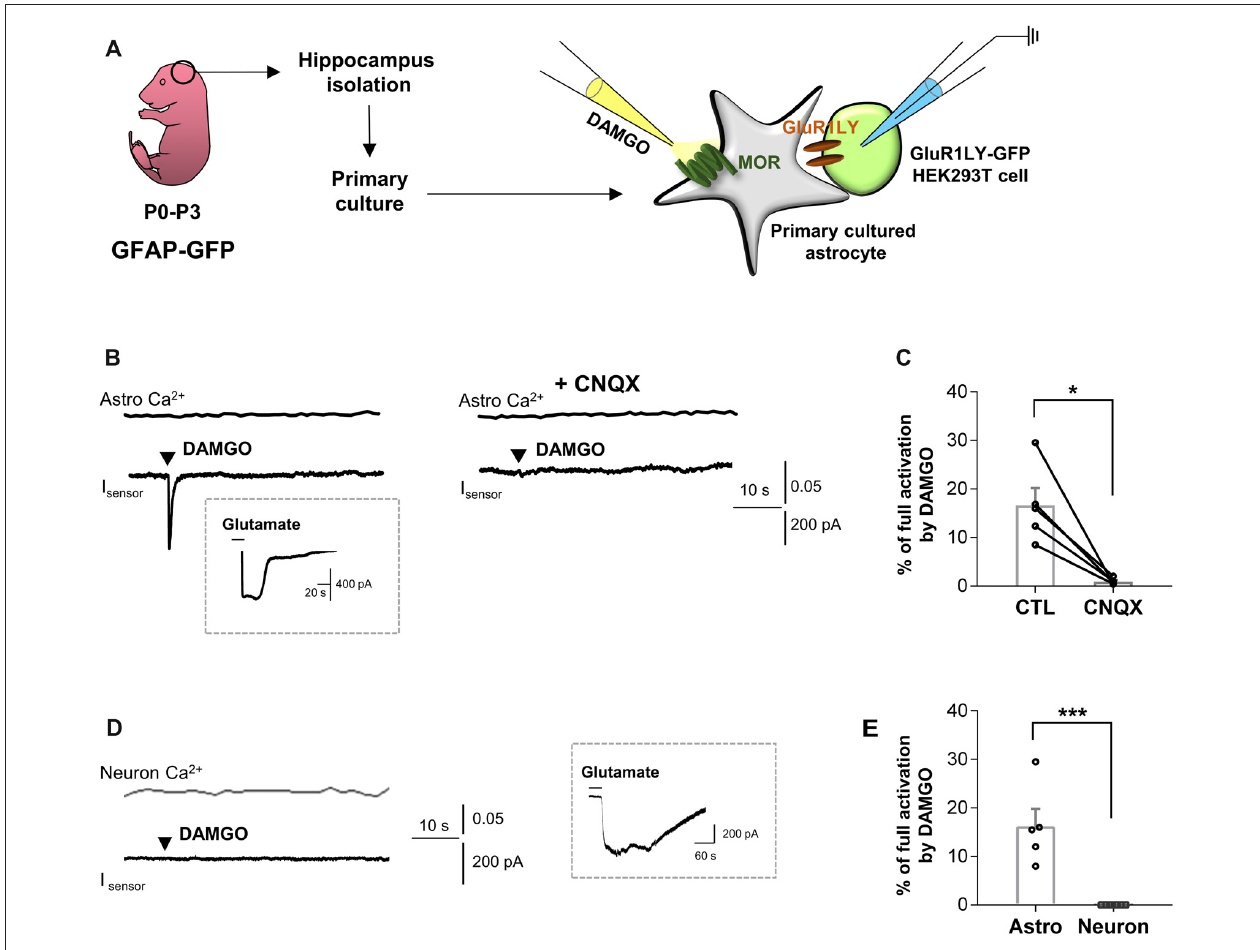
FIGURE 1 | µ -opioid receptor (MOR) activation elicits fast glutamate current from hippocampal astrocytes. (A) Schematic diagram for sniffer-patch with primary cultured hippocampal astrocytes prepared from GFAP-green fluorescent protein (GFP) mouse and GluR1LY-GFP-expressing HEK293T biosensor cells. (B) Ca 2 + response (Astro Ca 2 + ) induced by brief (0.1 ms) pressure application of 10 µ M [D-Ala 2 ,N-MePhe 4 ,Gly-ol]-enkephalin (DAMGO) from a pipette in acutely dissociated hippocampal astrocyte (upper trace) and simultaneously recorded inward current (I sensor ) from GluR1-L497Y expressing HEK293T cells (lower trace). DAMGO-induced inward current was inhibited by cyanquixaline (CNQX; 10 µ M) application. Inset figure indicates an example trace of full activation current by bath application of 1 mM glutamate to estimate the total surface expression of GluR1-L497Y. (C) Summary bar graph for DAMGO-induced glutamate current normalized by the full activation current. The data were expressed as means ± SEM. Data from two independent mice. Paired t -test ( ∗ P < 0.05). (D) Ca 2 + response (Neuron Ca 2 + ) induced by brief (0.1 ms) pressure application of 10 µ M DAMGO from a pipette in acutely dissociated hippocampal astrocyte (upper trace) and simultaneously recorded inward current (I sensor ) from GluR1-L497Y expressing HEK293T cells (lower trace). Inset figure indicates an example trace of full activation current by bath application of 1 mM glutamate to estimate the total surface expression of GluR1-L497Y. (E) Summary bar graph for DAMGO-induced glutamate current normalized by the full activation current Unpaired t -test ( ∗∗∗ P < 0.001). The data of astrocytes is identical to the control group in (C) . The data were expressed as means ± SEM. Data from two independent mice. Paired t -test ( ∗∗∗ P <